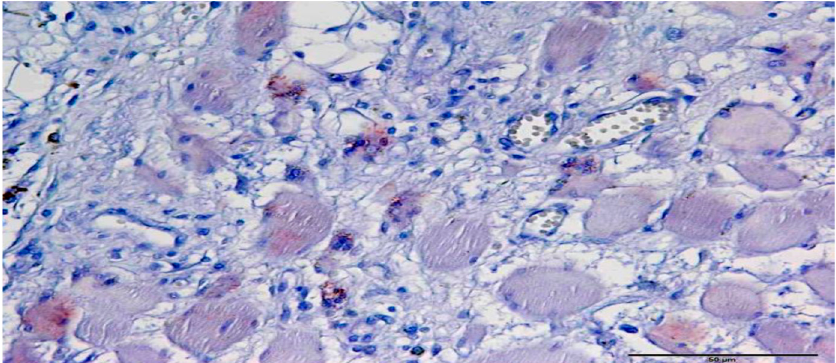
Figure 1. Immunohistochemical staining of Gli1 expression in a spinal chordoma. The expression strength of the cytoplasmic granular staining of the tumor cells corresponds to the score 1 (magnification 400 ×).